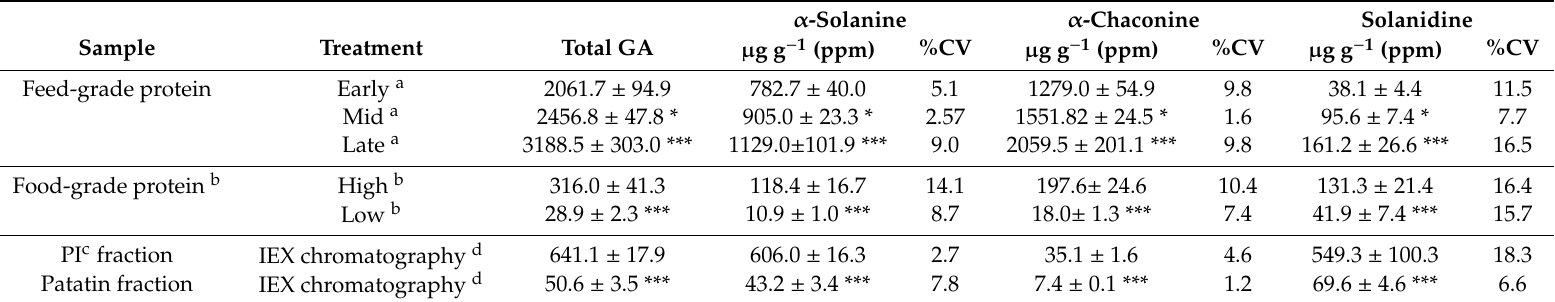
Table 4. Glycoalkaloid content in di ff erent potato protein isolates (means ± standard deviation, n = 6). α -Solanine α -Chaconine